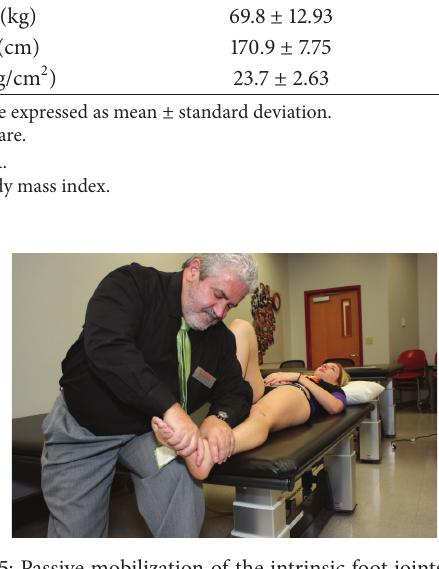
Figure 5: Passive mobilization of the intrinsic foot joints with the subject in supine lying. Passive movements were applied for 180 seconds to the dominant foot.